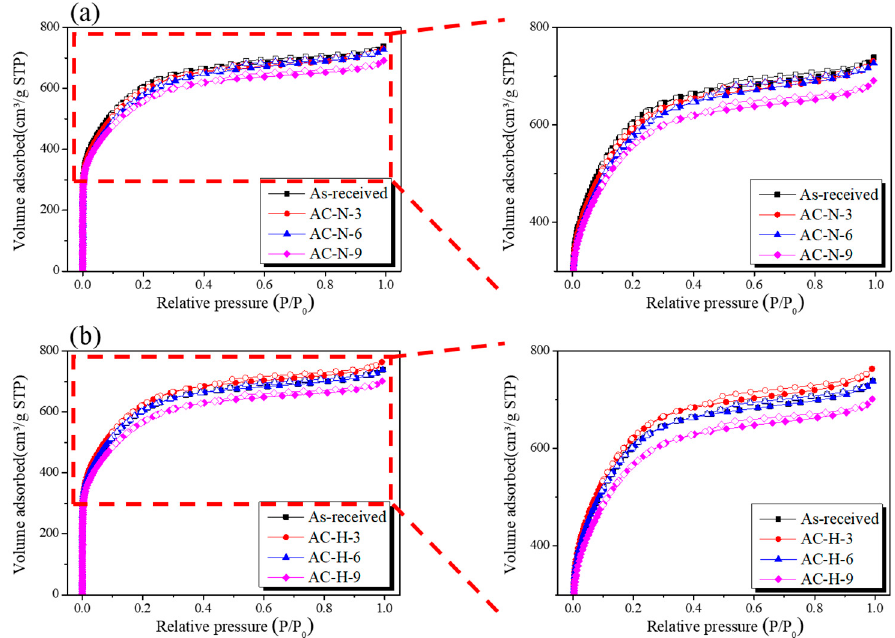
Figure 6. N 2 /77 K adsorption isotherms of AC heat-treated under different gas atmospheres: ( a ) N 2 and ( b ) H 2 /N 2 mixed gas.